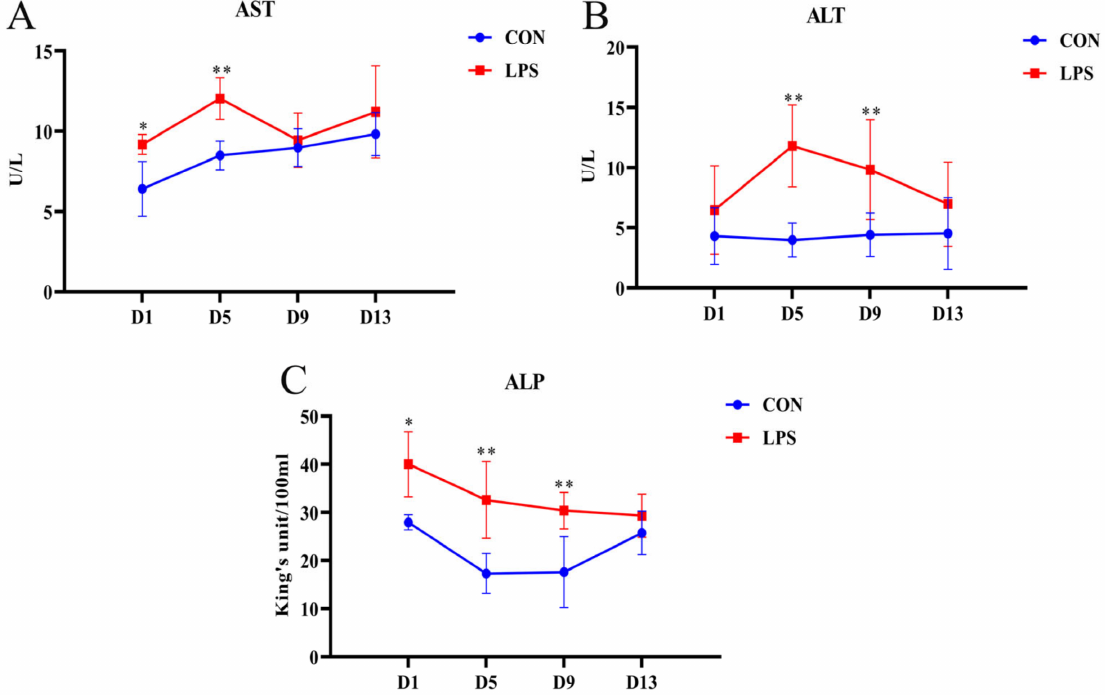
Figure 1. The dynamic changes in the serum enzyme activity of weaned piglets induced by LPS. Note: ( A ) AST, aspartate aminotransferase; ( B ) ALT, alanine aminotransferase; ( C ) ALP, alkaline phosphatase. “*” indicates a significant difference ( p < 0.05), and “**” indicates an extremely significant difference ( p <